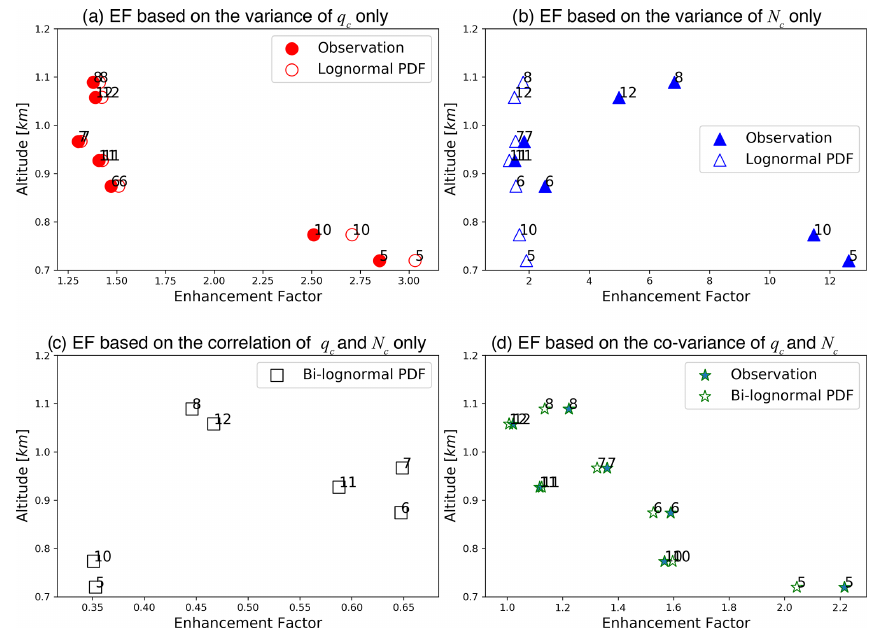
Figure 6. (a) E q as a function of height derived from observation based on Eq. (9) (solid circle) and from the inverse relative variance ν q assuming lognormal distribution based on Eq. (6) (open circle). (b) E N as a function of height derived from observation based on Eq. (10) (solid triangle) and from the inverse relative variance ν N assuming lognormal distribution based on Eq. (7) (open triangle). (c) E COV derived based on Eq. (8) as a function of height. (d) E as a function of height derived from observation based on Eq. (3) (solid star) and based on Eq. (5) assuming a bi-lognormal distribution (open star). The numbers beside the symbols in the figure correspond to the numbers of the seven selected